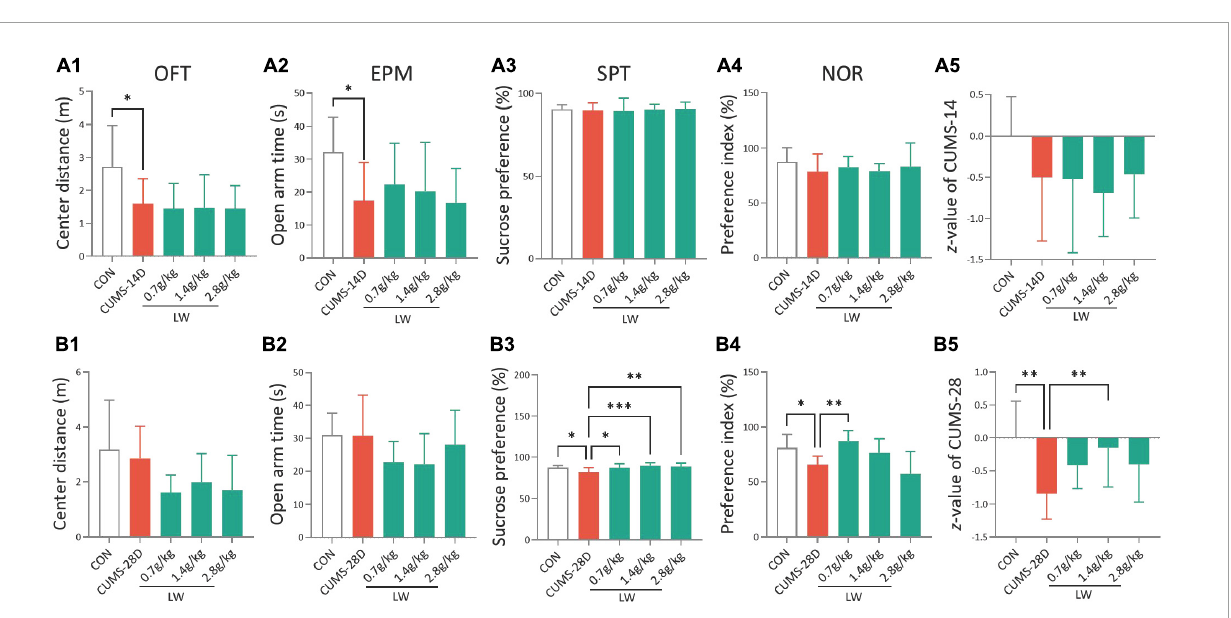
the preferential index ( Figure 2B4 ). The